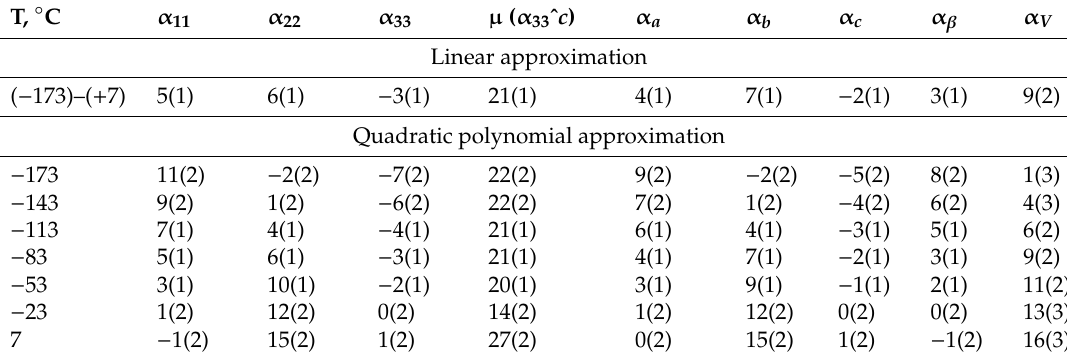
Table 4. Thermal expansion coe ffi cients (TECs) ( × 10 6 ◦ C − 1 ) of hingganite-(Y) along the principal axes of the thermal expansion tensor and along crystallographic axes.